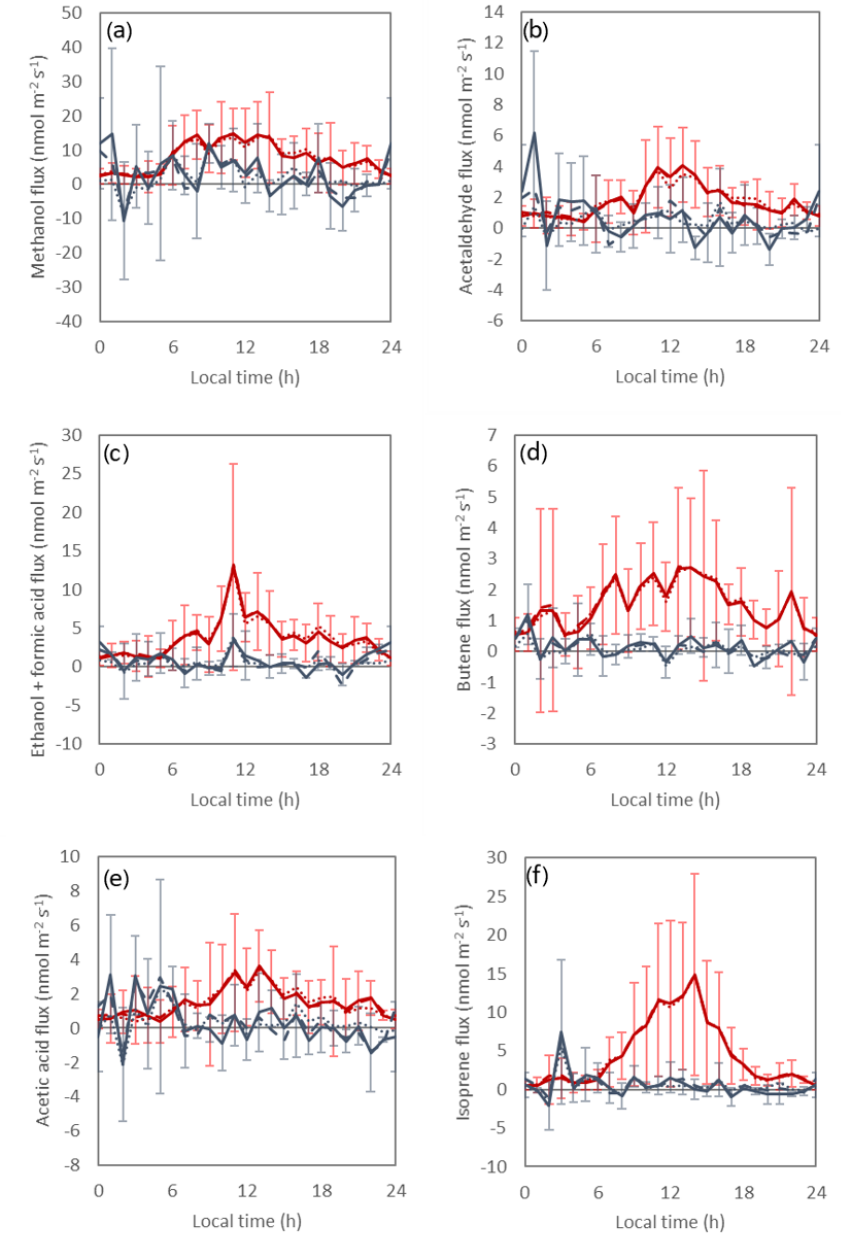
Figure 6. Diurnal cycles of the fluxes of six compounds with the largest observed fluxes for the summer (red) and winter (blue) campaigns, with error bars showing standard deviation of the stationarity filtered fluxes and fluxes including the storage term (solid lines). Dashed lines represent the flux without the storage term, and dotted lines are u ∗ filtered fluxes, including the storage term, and are gap-filled with the average flux above the u ∗ threshold for that